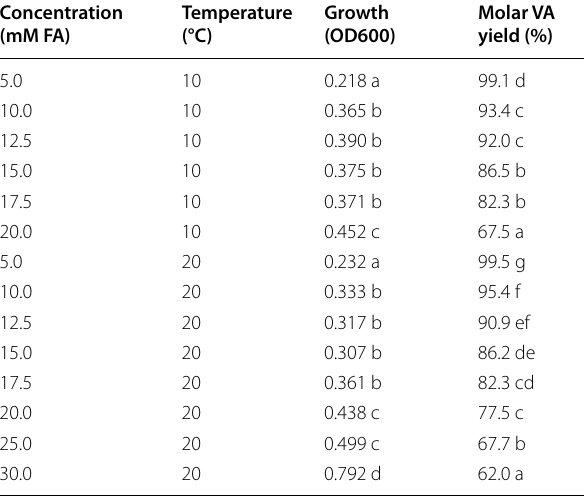
Data represent mean values of three replicates. Different letters (a-f) indicate statistically significant differences (LSD,